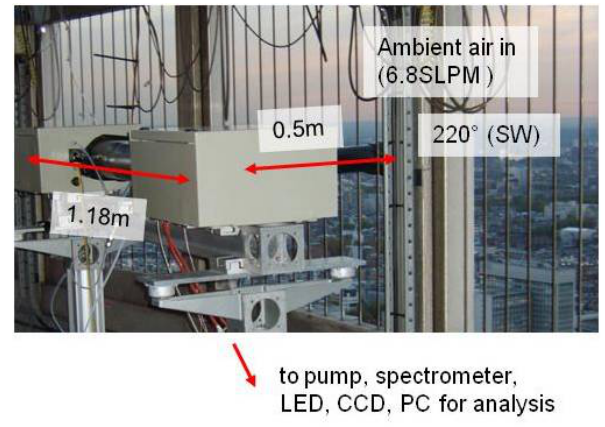
Fig. 2. The LED-BBCEAS setup on the balcony of level T35 of the BT Tower,